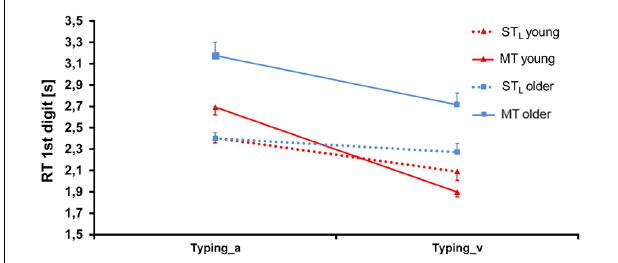
FIGURE 9 | Reaction time (RT) ± SE in the typing task for both age groups in single task (ST D ) and multitask (MT) conditions. The typing task was presented auditorily (_a) and visually (_v).